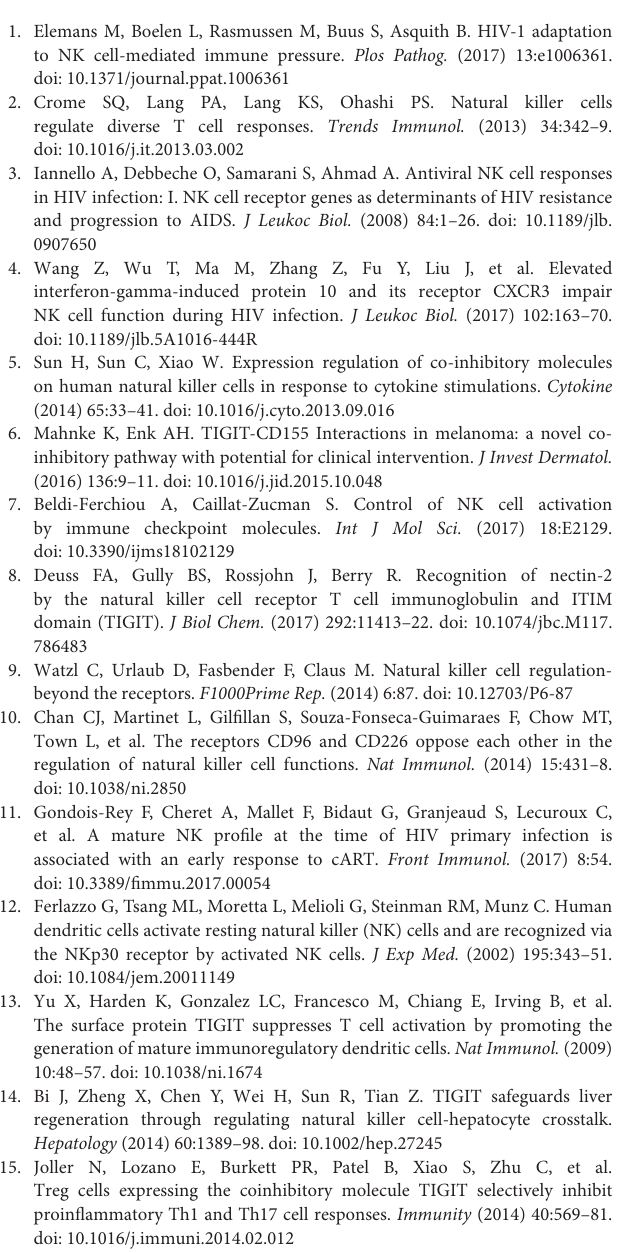
absolute CD4 + T cell counts (cells/mm 3 ) at the same sampling time ( n = 53). (F) Analysis of the correlation between TIGIT expression on CD56 bright CD16 − / + NK cells and absolute CD4 + T cell counts (cells/mm 3 ) at the same sampling time ( n = 53). (G) Analysis of the correlation between TIGIT expression on CD56 dim CD16 + NK cells and absolute CD4 + T cell counts (cells/mm 3 ) at the same sampling time ( n = 53). (H) Analysis of the correlation between TIGIT expression on CD56 dim CD16 − NK cells and absolute CD4 + T cell counts (cells/mm 3 ) at the same sampling time ( n = 53). The Mann-Whitney test was used for comparisons between two groups, and the Kruskal-Wallis test for comparisons among the four groups. Error bars indicate median and interquartile range. p < 0.05 was considered